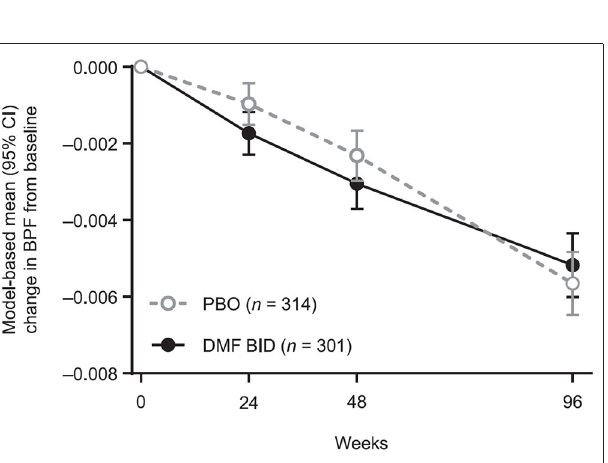
FIGURE 2 | Model-based mean BPF changes from baseline, showing temporal patterns of brain volume changes by treatment in the pooled study populations. Results are obtained from a repeated measures model for change from baseline in BPF. The model includes treatment, study, week, and their